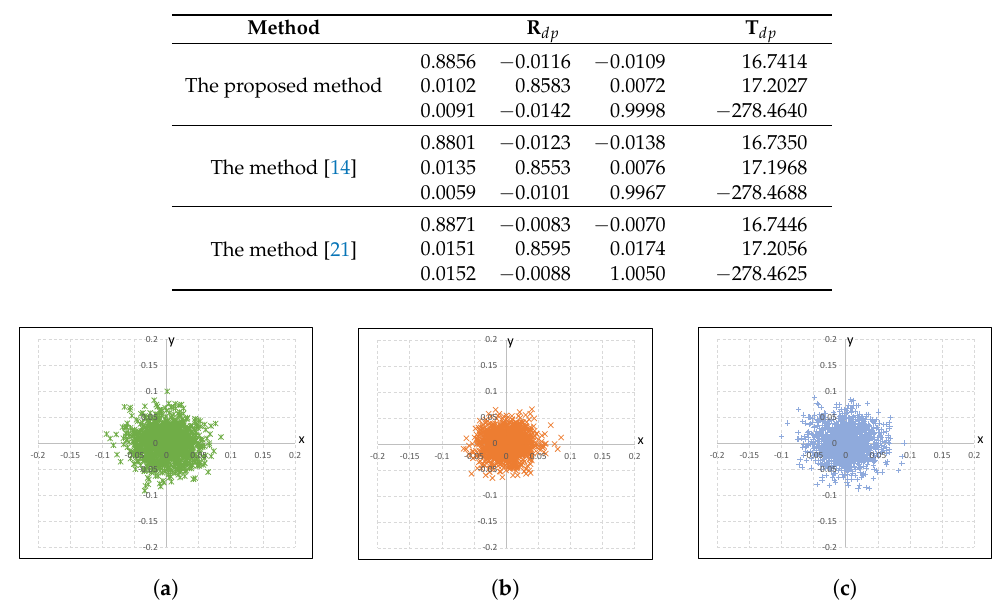
Figure 9. 2D histograms of the re-projection errors, which are calculated with respect to the projector image coordinates: ( a ) the RGB camera based method (std = 0.027), ( b ) the depth camera based method (std = 0.029), ( c ) the proposed method (std =